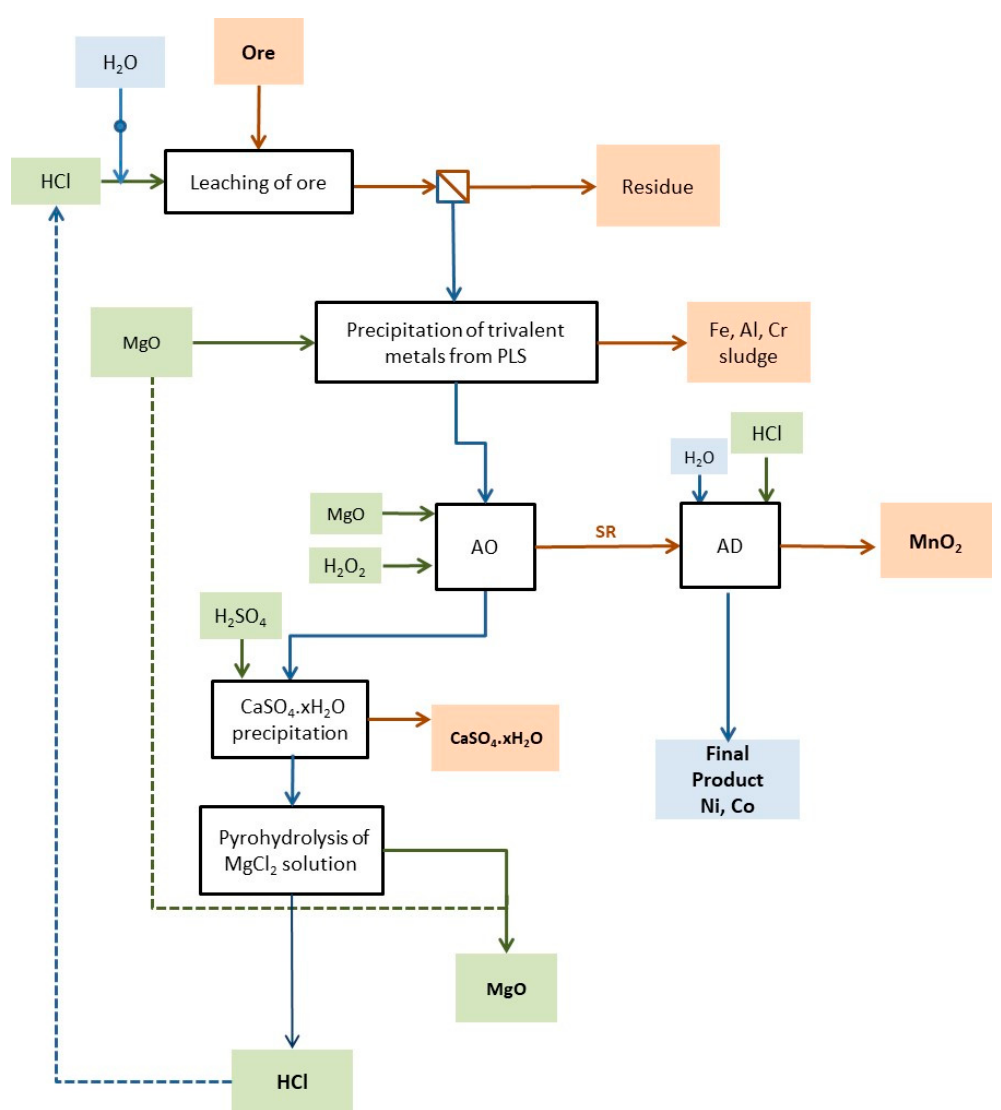
Figure 1. The main steps of the investigated HCl leaching process for the treatment of laterite ores.